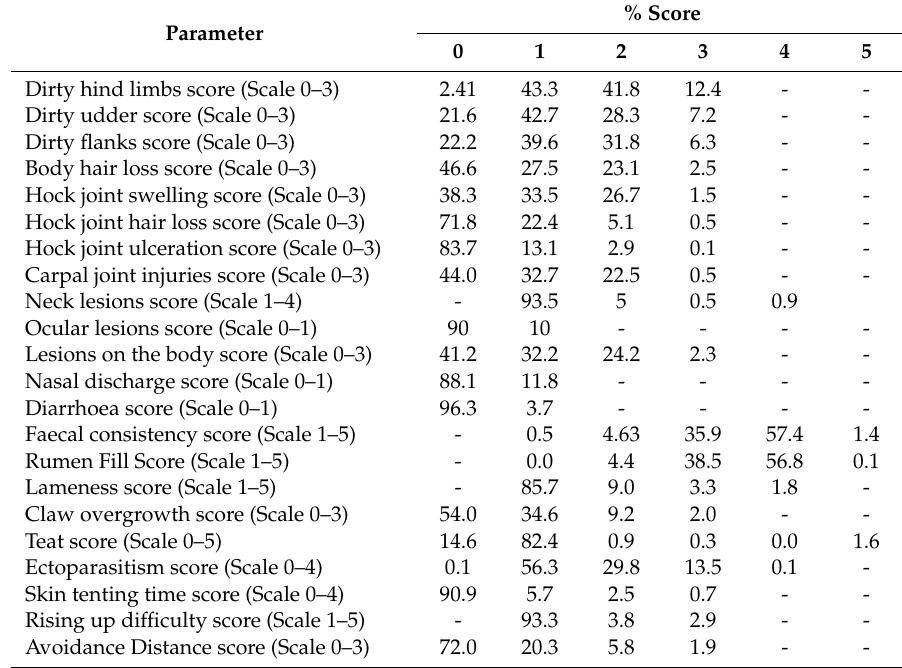
Table 2. Distribution of di ff erent animal-based welfare parameters in 54 cow shelters ( n = 540